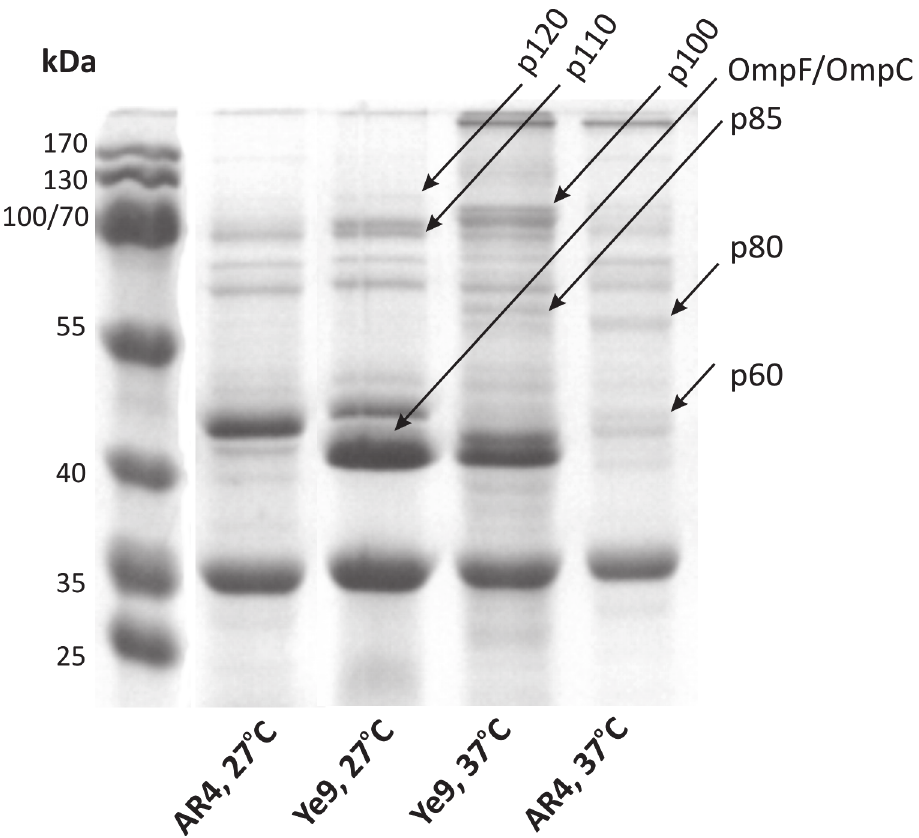
Fig 2. Influence of OmpR activity on the Y . enterocolitica membrane protein profile. Proteins were isolated from strains Ye9 (wild type) and AR4 ( ompR mutant) grown overnight in LB medium at 27°C or 37°C. In each case, 50 μ g of protein were separated by SDS-PAGE and visualized by Coomassie blue staining. Putative OmpR-regulated proteins subsequently identified by LC-MS/MS are indicated by arrows. The bands were named according to their migration in the 12% polyacrylamide gel relative to the molecular weight standards.